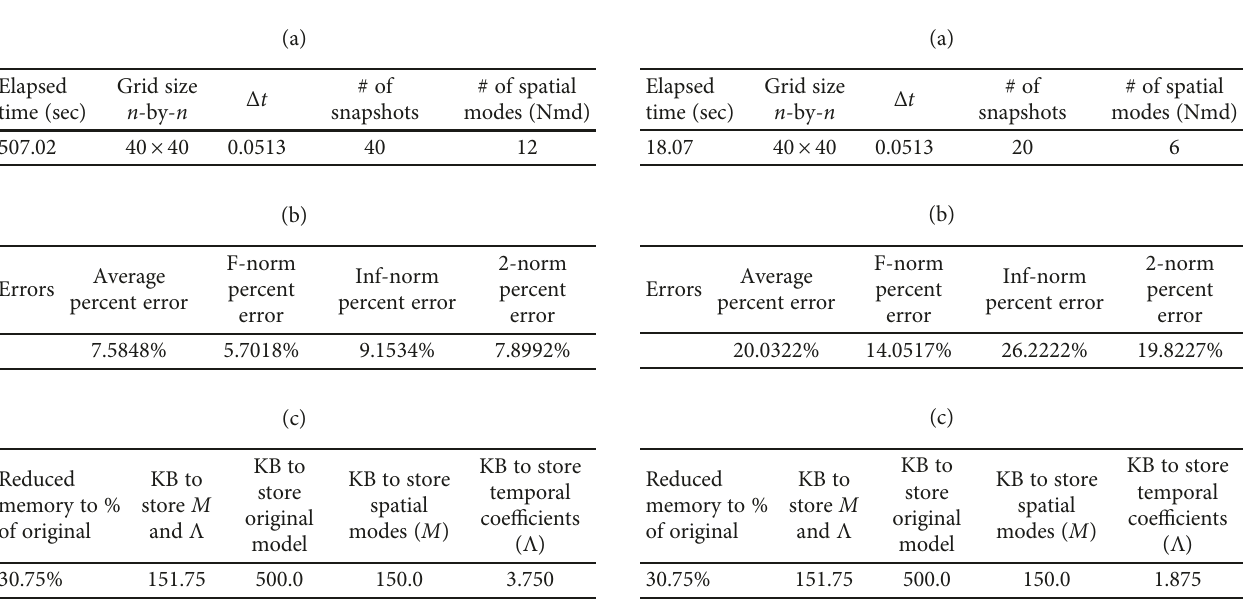
Algorithm 2 Fitted exponential curve Figure 3: Relationship of spatial modes with percent error and run time. Table 5: Algorithm 2 results (40 × 40 grid and 40 time